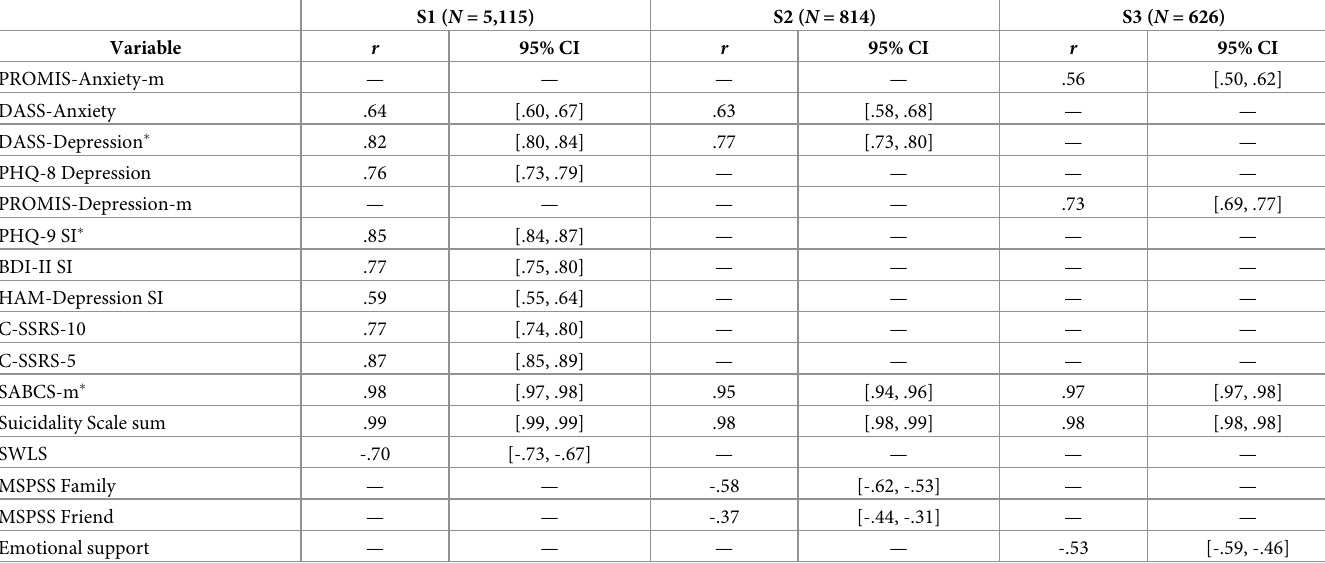
Table 8. Partial correlations between psychosocial variables and Suicidality Scale ability scores. S1 ( N =